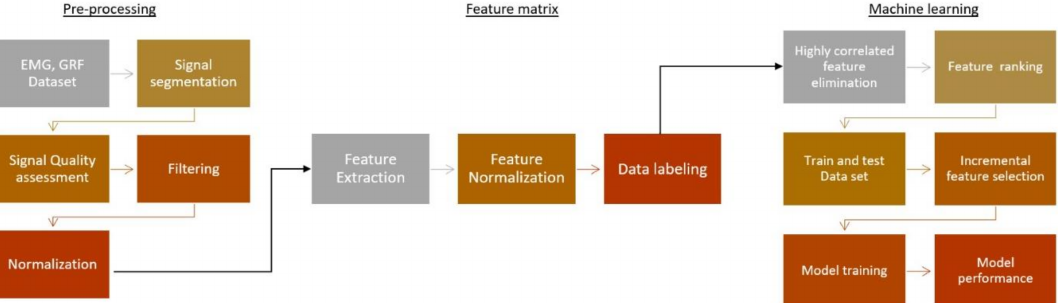
Figure 2. Flow chart of the data processing and ML model performance analysis for DN and DFU patients’ identification using EMG and GRF features.